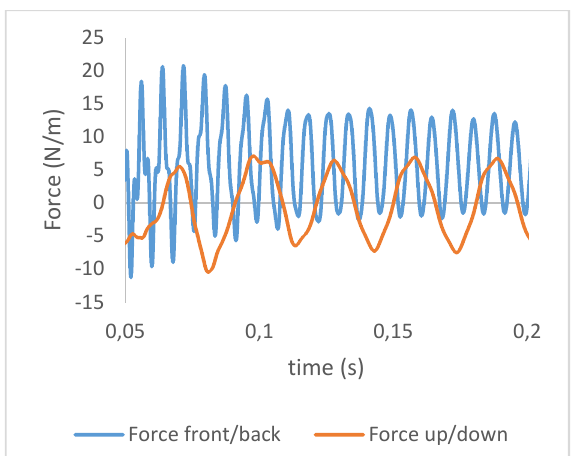
Fig. 11. Force acting on the glass element surface in flow direction and perpendiculatr to it for a flow velocity of 36 km/h.